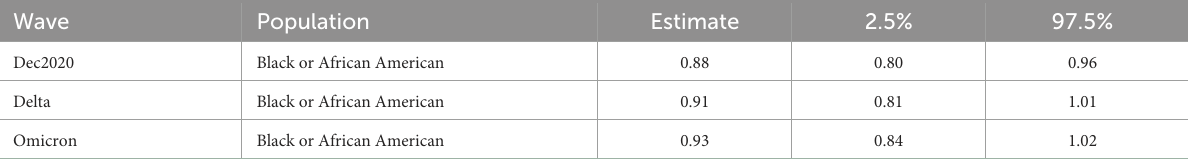
TABLE 3 Odds ratio and 95% confidence interval for remdesivir treatment while hospitalized for COVID comparing Black and White inpatients. Wave Population Estimate 2.5% 97.5% Dec2020 Black or African American 0.88 Delta Black or African American